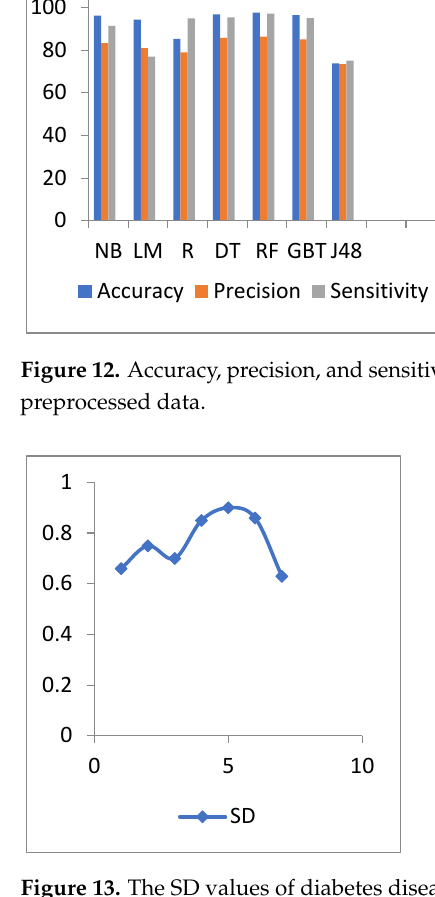
Figure 13. The SD values of diabetes disease